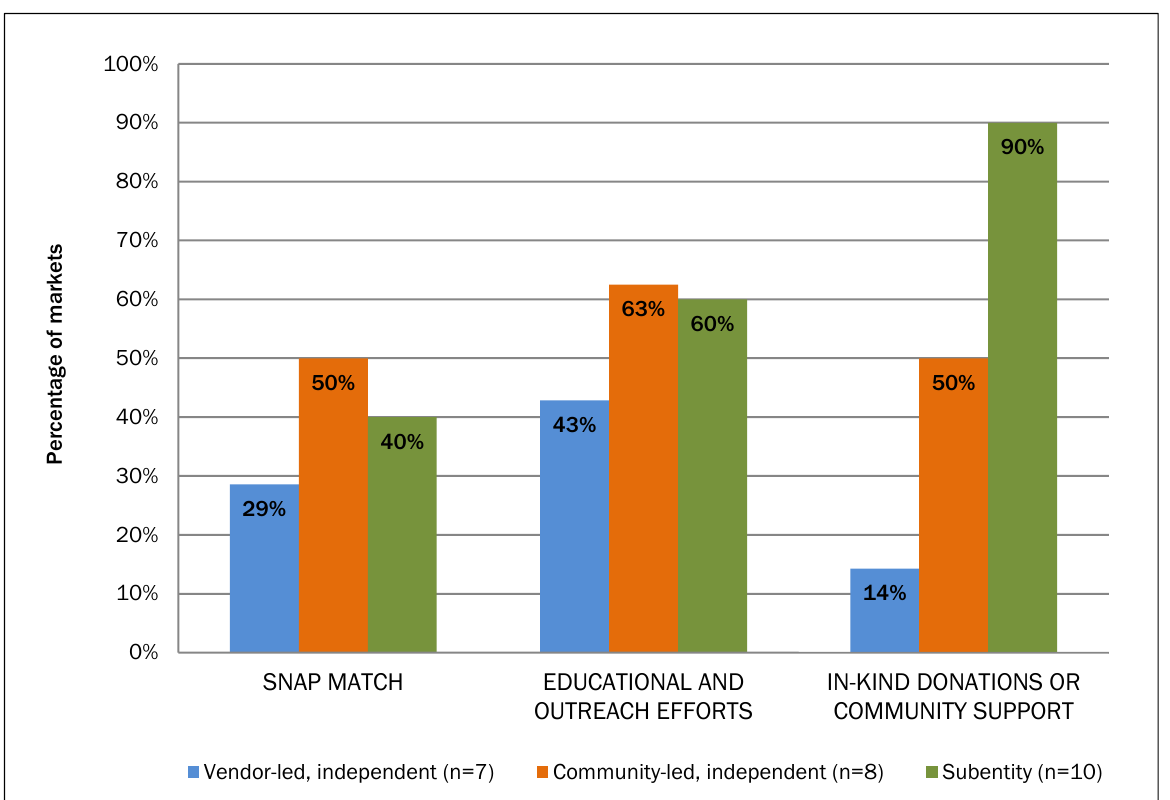
Figure 2. Social Programs, Outreach Efforts, and Community Support (Percent Implementing Programs or Receiving Community